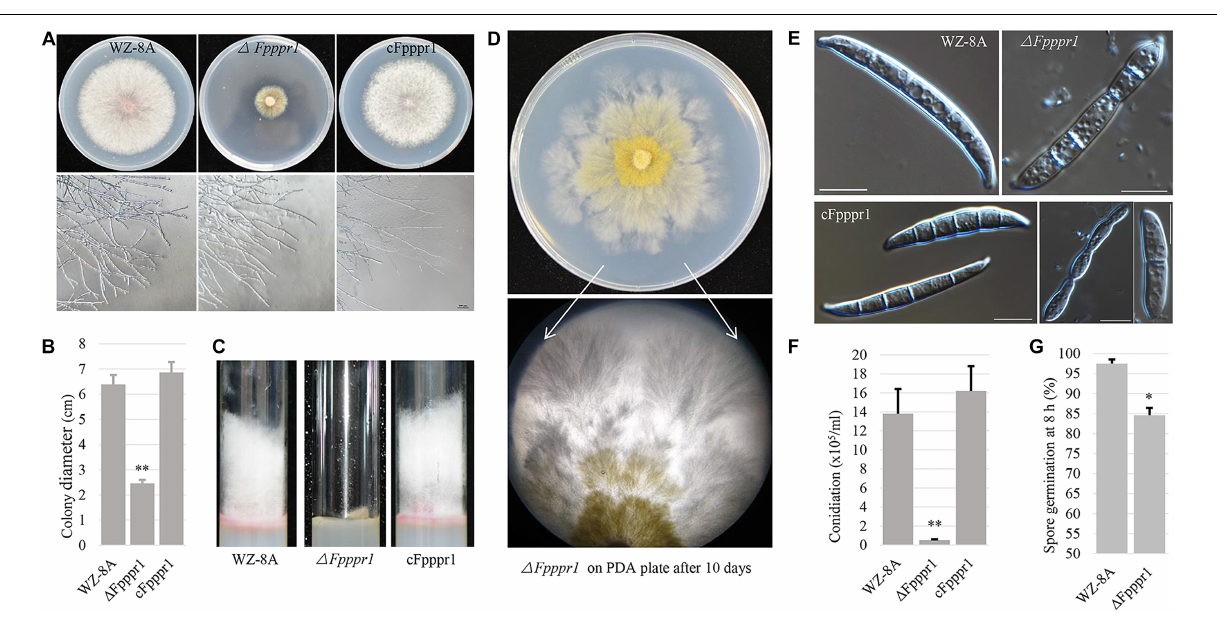
SUB7037132) 13 . A total of 1,367 genes were differentially down- regulated, while 1,333 genes were differentially up-regulated